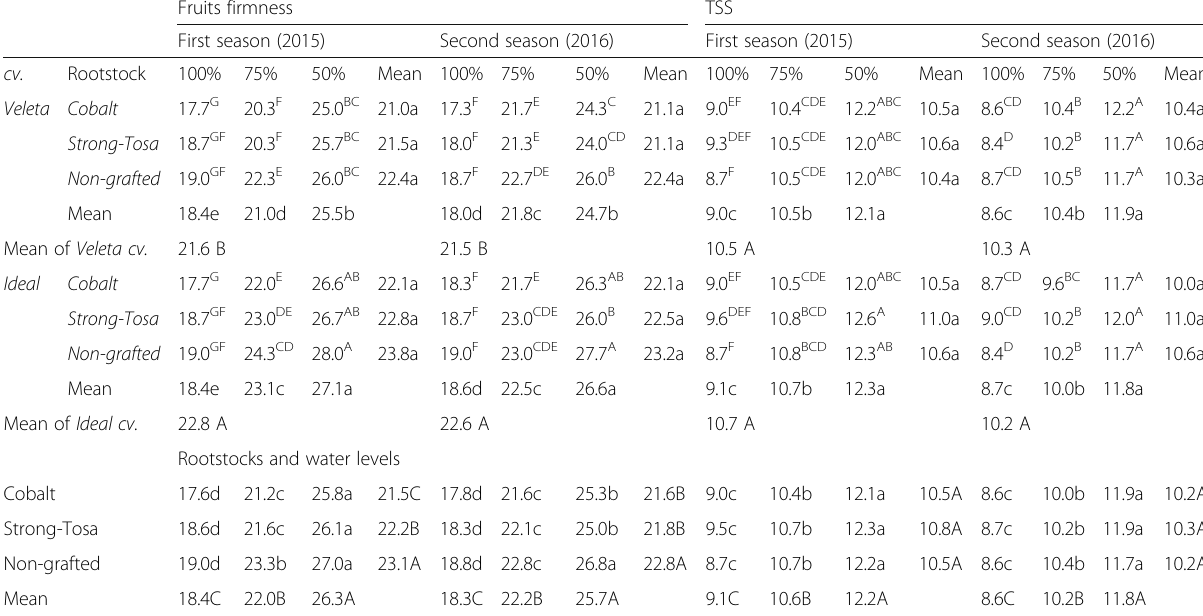
Table 3 Effect of deficit irrigation rates, cultivars and rootstocks on firmness and TSS of fruit for cantaloupe plants during 2015 and 2016 seasons